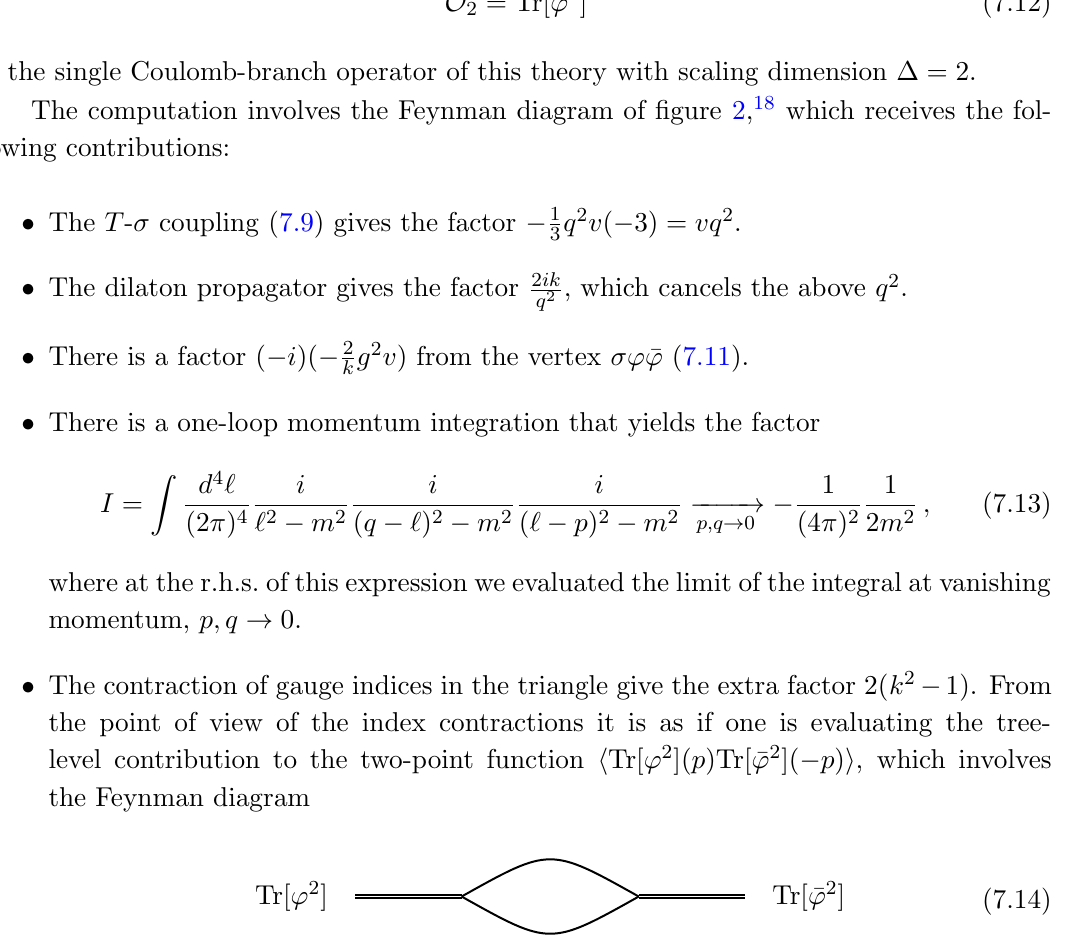
Figure 2 . The Feynman diagram that determines the leading contribution to G H SCQCD